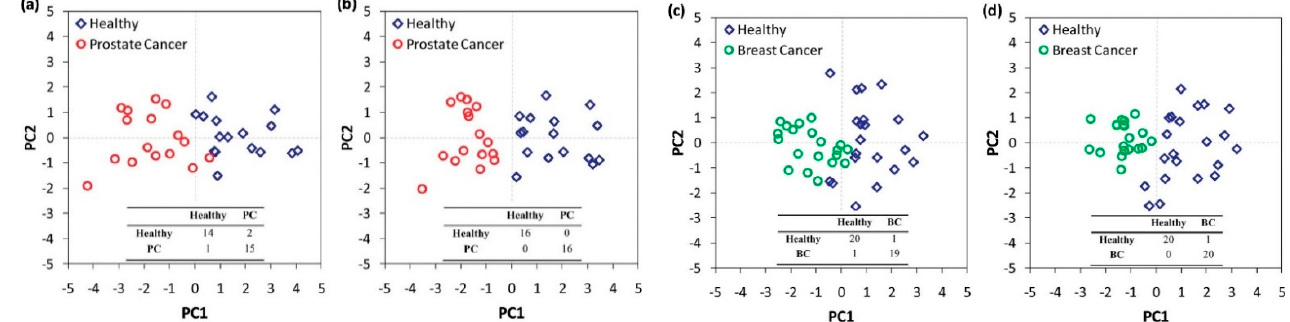
Figure 3. Statistical analysis of the response of a nanomaterial-based, cross-reactive chemiresistor for real-world samples of sick and healthy subjects. The use of PCA permits the differentiation of the groups. Notably, relative humidity compensation reduces the dispersion of different clusters thereby improving the discrimination between healthy and sick subjects. Representative 2D breath-analysis PCA plots for prostate cancer diagnosis: ( a ) without relative humidity compensation; ( b ) with relative humidity compensation. PCA plots for breast cancer diagnosis: ( c ) without relative humidity compensation; ( d ) with relative humidity compensation. Adapted with permission from Ref. [42] Copyright © 2012, American Chemical Society.